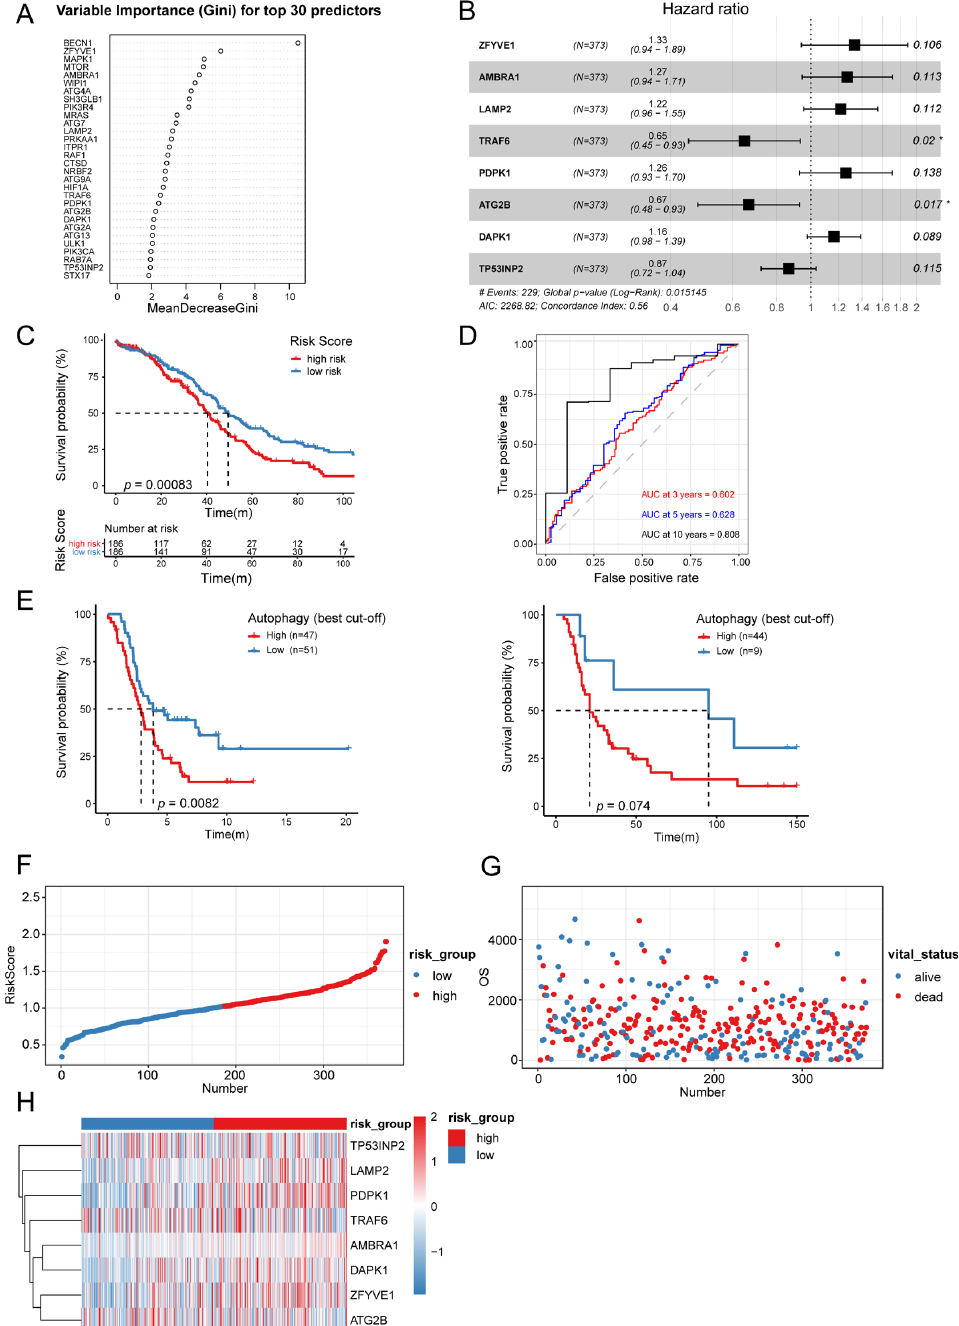
Figure 5. Development of an autophagy-related signature: ( A ) Ranking of top thirty autophagy hub genes based on their importance in the autophagy process. ( B ) Selection of eight risk genes by stepwise multivariate Cox proportional risk regression analysis. ( C ) Kaplan-Meier analysis of the survival outcomes of patients (TCGA) with high or low autophagy risk scores. ( D ) Time-dependent ROC curves analysis of the prognostic accuracy of the autophagy-related signature at 3 years, 5 years and 10 years. ( E ) Kaplan-Meier analysis of the survival outcomes of patients with high or low autophagy risk scores in the validation cohorts from GEO. Left: GSE14407; Right: GSE38666. ( F ) The distribution of the autophagy risk scores in OC patients from TCGA cohort. ( G ) The survival status of the OC patients in autophagy-high/low risk group. ( H ) The expression levels of the eight risk genes in autophagy-high/low risk group.